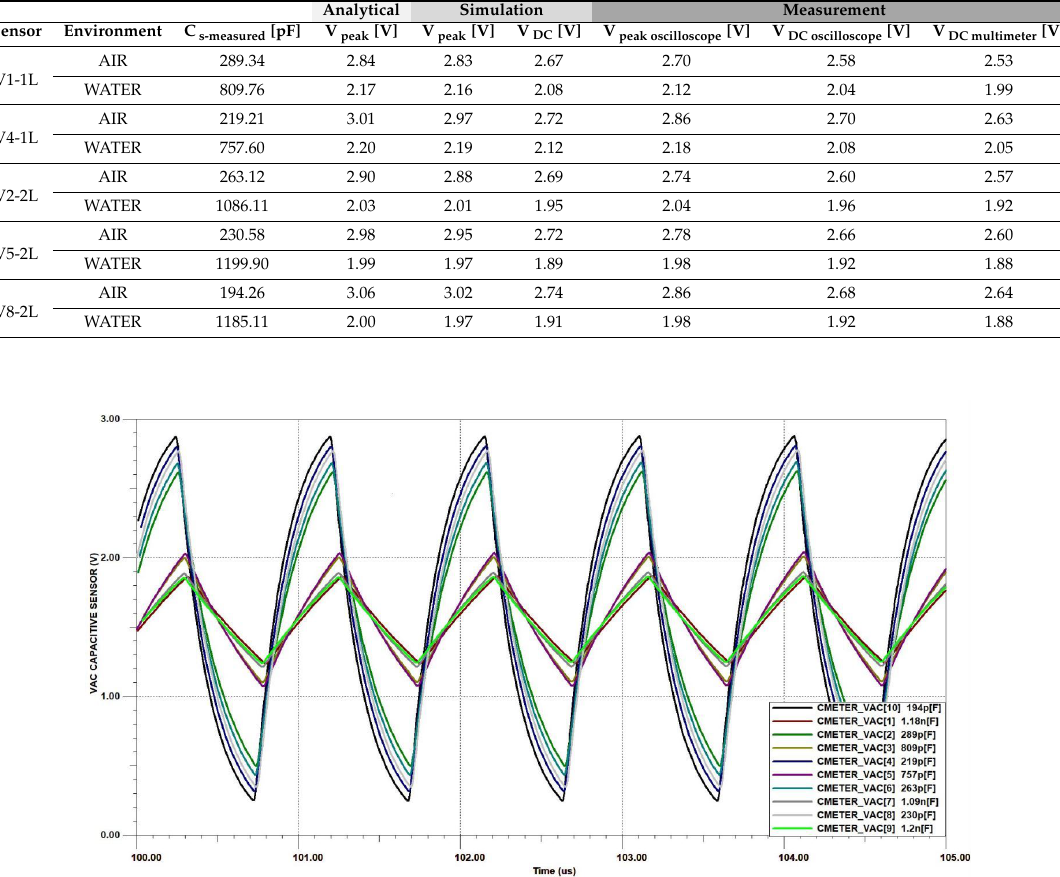
Figure 10. Simulated AC voltage at the capacitor sensor using TINA-TI from Texas Instruments for values corresponding to sensors V1-1L, V4-1L, V2-2L, V5-2L and V8-2L. The simulation schematic is the one from Figure 4b.